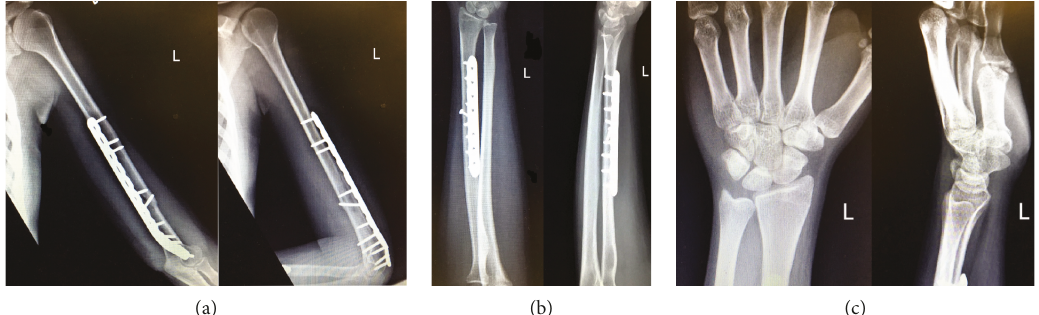
Figure 3: One year postoperative AP and lateral radiographs of the left humerus (a), forearm (b), and wrist (c) demonstrating healing of both humeral and radial shaft fractures and maintenance of reduction of the distal radioulnar